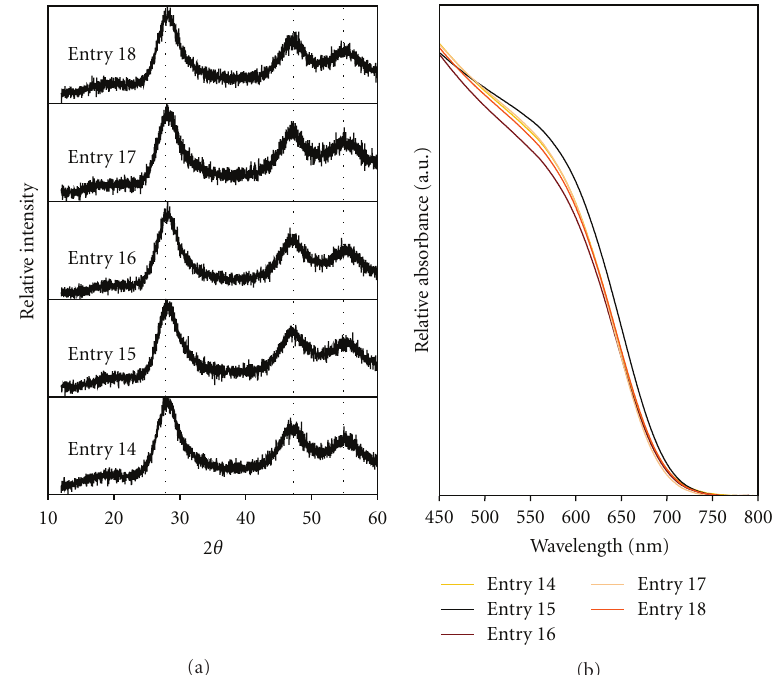
Figure 7: (a) Normalized XRD data of CuIn 0 . 72 Ga 0 . 28 S 2 soluble nanoparticles prepared 195 ◦ C. (b) Normalized UV-Vis absorption spectra of CuIn 0 . 72 Ga 0 . 28 S 2 soluble nanoparticles prepared 195 ◦